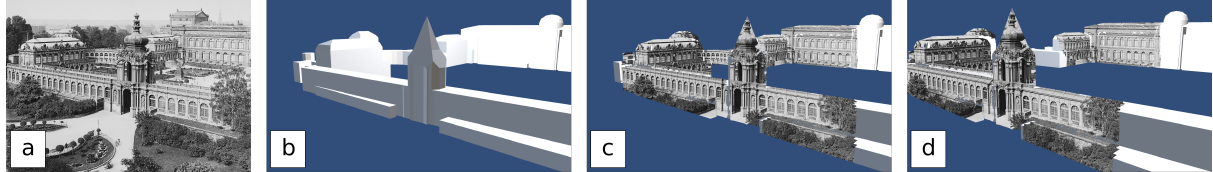
Figure 5. (a) Historic depiction of Dresdner Zwinger. (b) LOD2 CAD model provided by the city municipality. (c) Projection of image to model and usage as texture. (d) Changing viewpoint with applied texture, structures hidden in the original image are left blank.